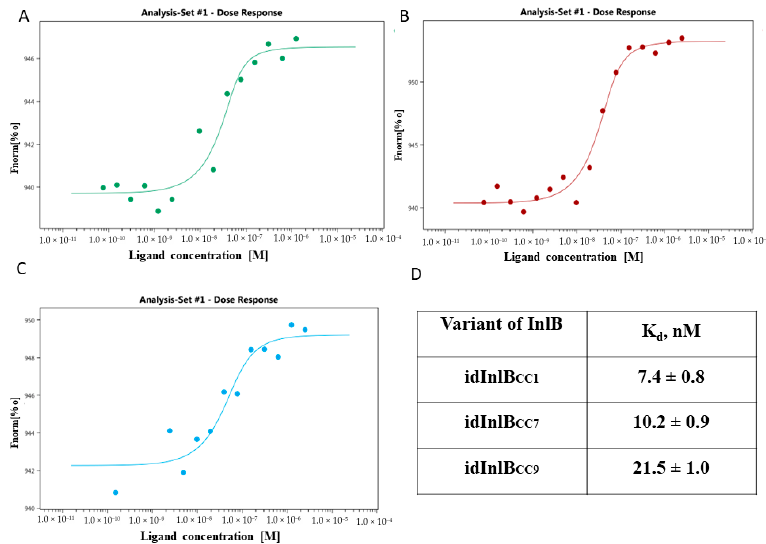
Figure 2. MST binding curves of idInlB CC1 ( A ), idInlB CC7 ( B ) and idInlB CC9 ( C ) with gC1qR. The gC1qR were titrated against fluorescent labeled 50 nM idInlB variants. The normalized thermophoresis value Fnorm% was plotted against the gC1qR concentration. Data of one from three independent measurements are shown. ( D ) Mean values of dissociation constants (K d ) ± standard deviation for human gC1qR binding with InlB variants from three independent experiments.